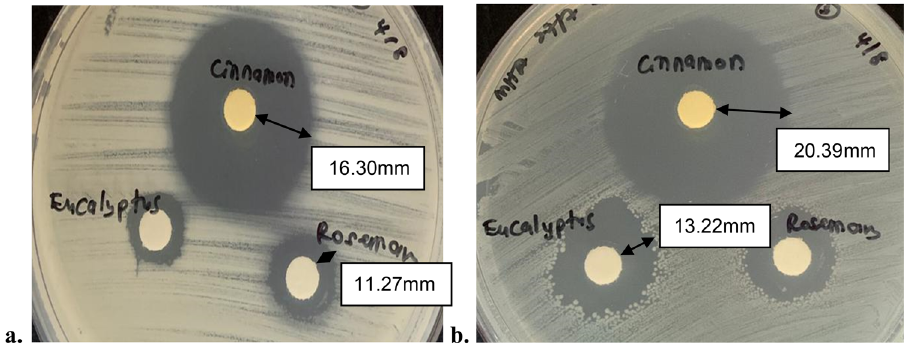
Figure 9: ( a ) Image of inhibition zone against B. subtilis and ( b ) inhibition zone against E. coli.